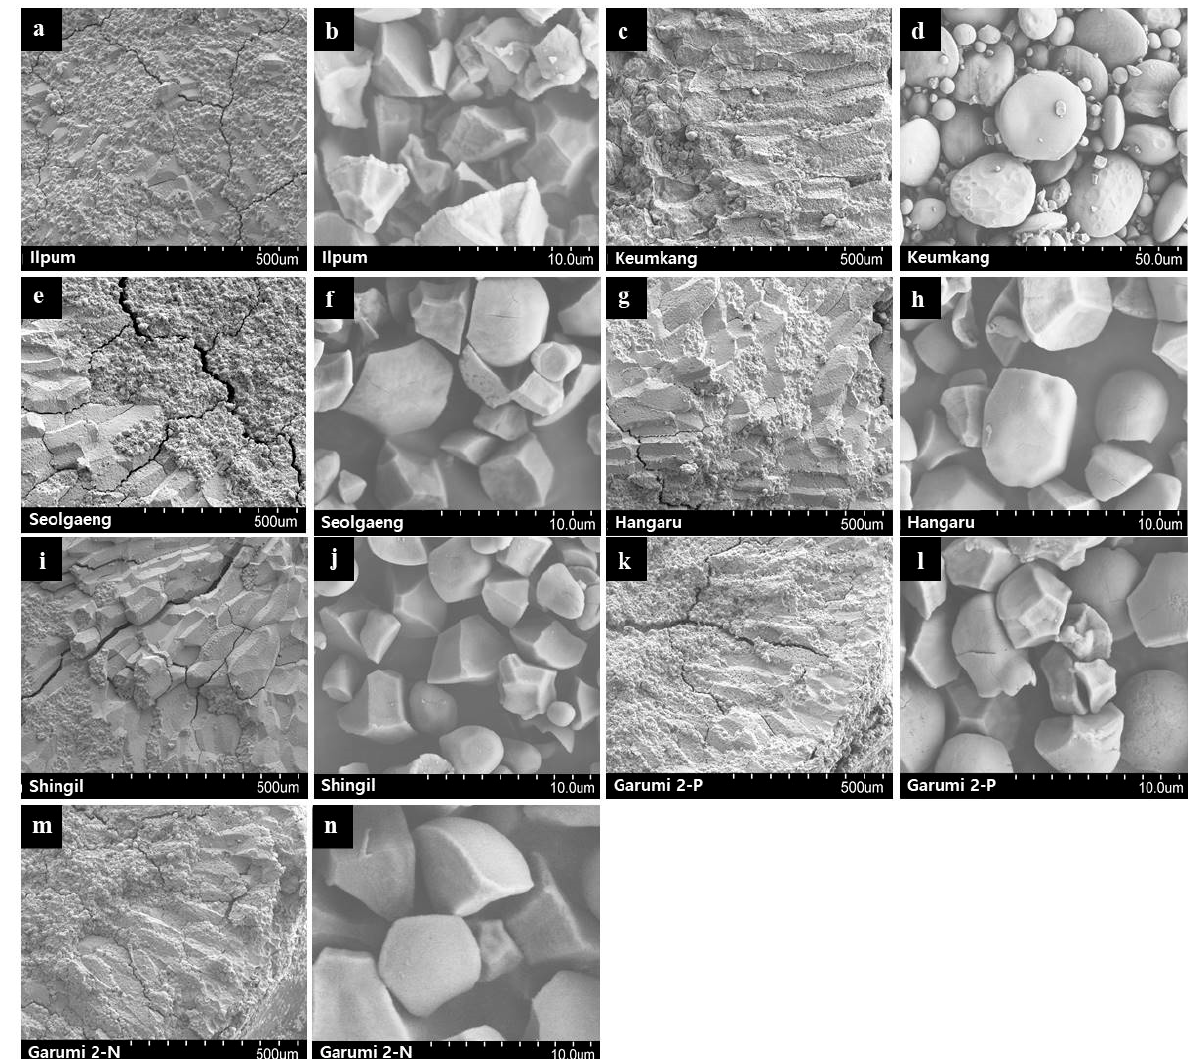
Figure 2. SEM of flour and starch granules isolated from six rice and one wheat varieties. ( a , b ) Ilpum, ( c , d ) Keumkang, ( e , f ) Seolgaeng, ( g , h ) Hangaru, ( i , j ) Shingil, ( k , l ) Garumi 2-P, and ( m , n ) Garumi 2-N.